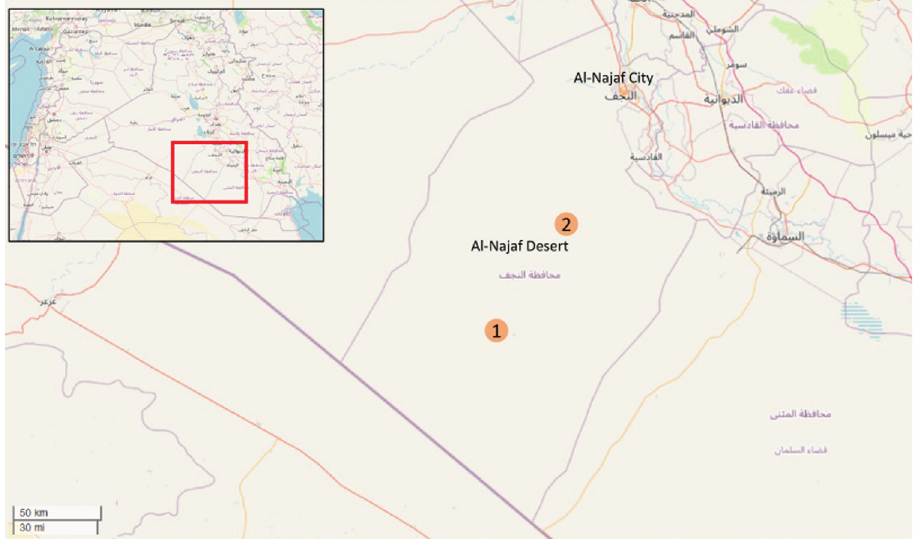
Figure 4. Geographic range and distribution map of Rhazya stricta in